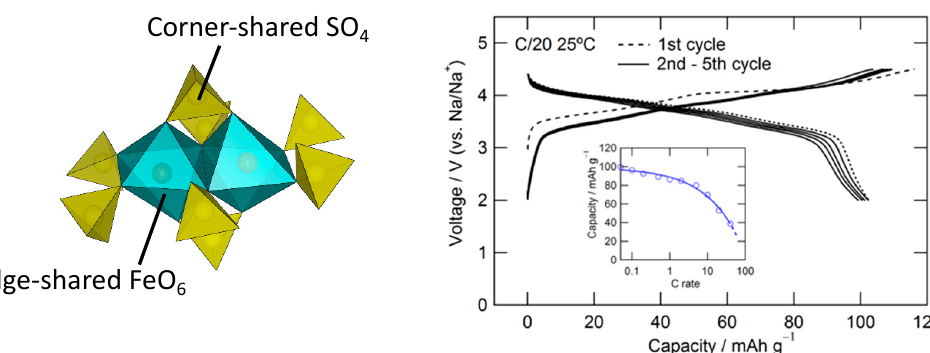
Figure 4. Local coordination structure and charge–discharge voltage profile of Na 2 Fe 2 (SO 4 ) 3 .